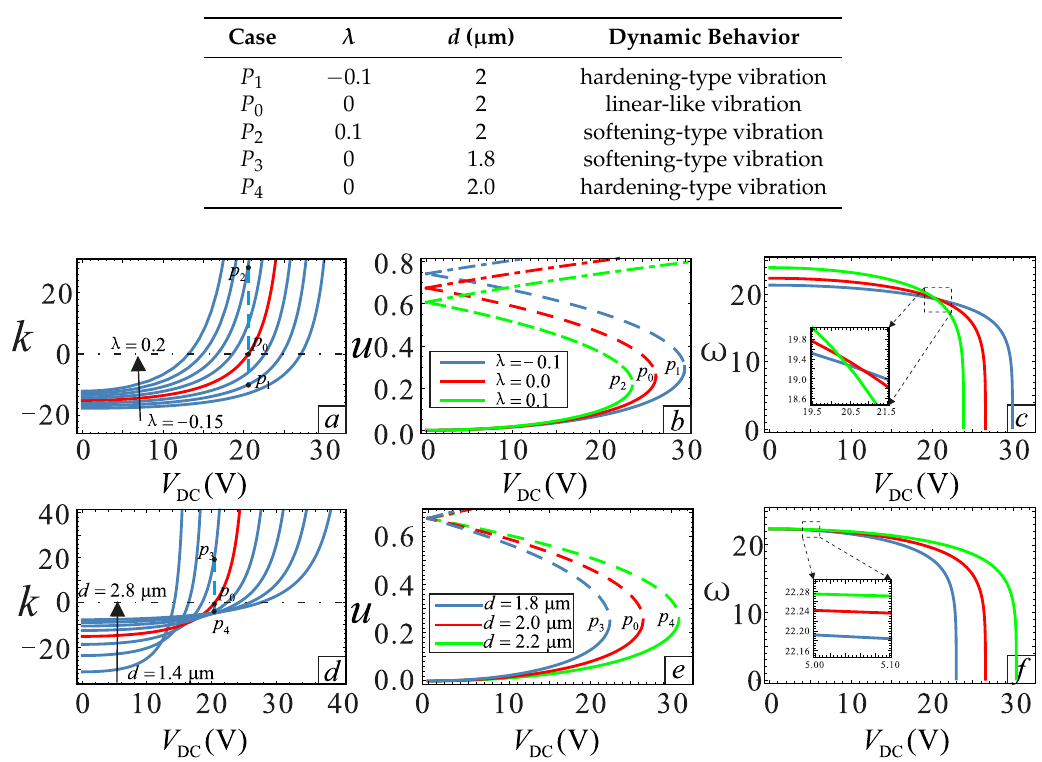
Figure 5. Relationship between DC voltage and mechanical behaviors under different physical parameters. ( a – c ) are the relationship between DC voltage and nondimensional parameter ĸ , static equilibrium and equivalent natural frequency, respectively, under different section parameters with d = 2.0 μ m. ( d – f ) are the relationship between DC voltage and nondimensional parameter ĸ , static equilibrium and equivalent natural frequency, respectively, under different gap distance with λ = 0. The solid lines represent the stable solution. The dashed lines represent the unstable solution. The dotted lines also represent a stable case, but it is impossible for them to appear in the physical model.